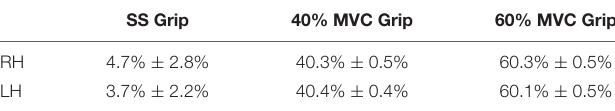
Frontiers in Human Neuroscience |